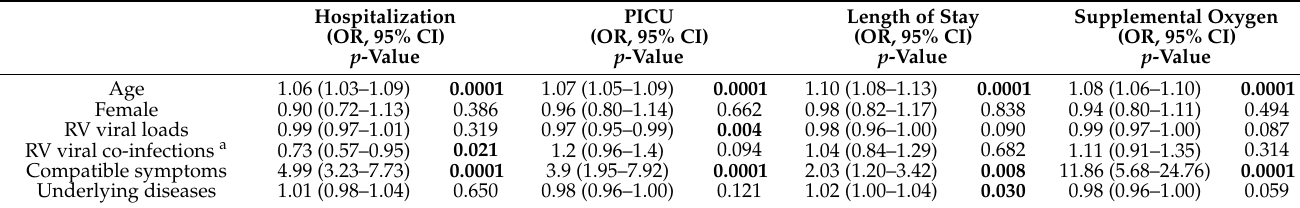
Table 6. Multivariable logistic regression of risk factors associated with disease